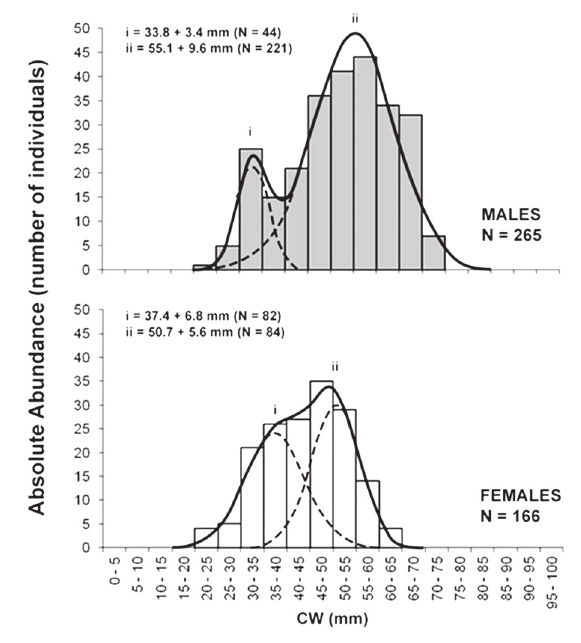
Figure 2 . Ucides cordatus (Linnaeus, 1763). The absolute abundance of each sex by size class (CW) captured in the mangroves of the Joanes River, Lauro de Freitas Municipality (Bahia State, Brazil) between September 2011 and August 2012. Normal curves are shown by dashed lines (i and ii) and represent the normal components in each sex (mean ± standard deviation), and the continuous curve represents their average. N is the number of individuals and CW is carapace width.